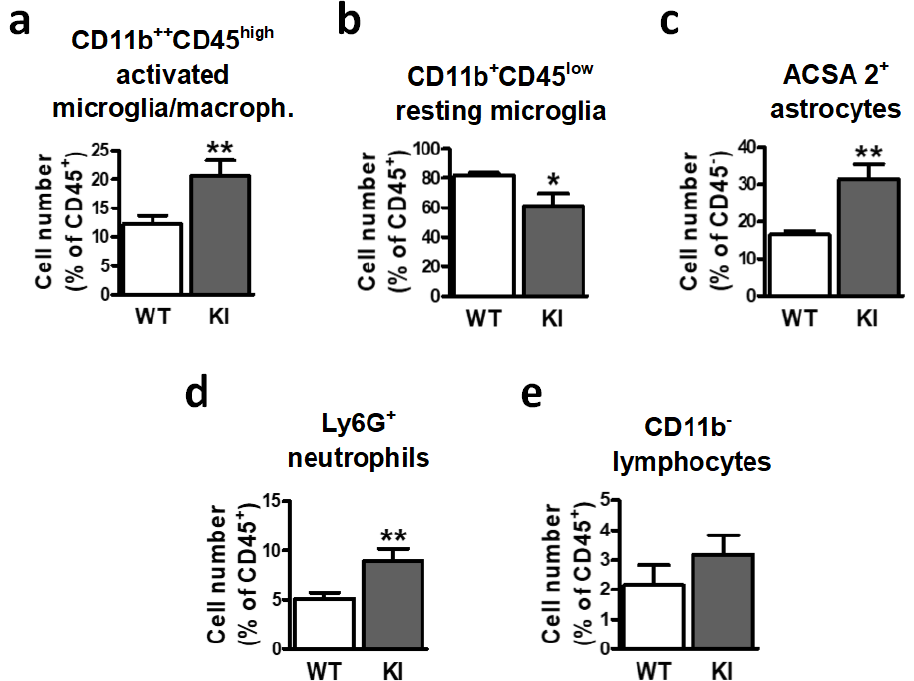
Figure 1. Inactivation of GSK3β by Ser 389 phosphorylation affects brain cell populations implicated in neuroinflammation. Brains from both WT and GSK3β Ser 389 KI mice were removed and processed for flow cytometry analysis of ( a ) CD11b ++ CD45 high activated microglia/macrophages, ( b ) CD11b ++ CD45 low resting microglia, ( c ) ACSA-2 + astrocytes, ( d ) Ly6G + neutrophils, and ( e ) CD11b − lymphocytes. Histograms represent cell number, expressed as the percentage of CD45 − cells (astrocytes) or CD45 + cells (all other populations). Data are shown as mean ± S.E.M ( n = 7-9). Student t -test was applied to compare genotypes. *, p < 0.05; **, p < 0.01. WT, wild-type; KI, and GSK3β Ser 389 knockin.